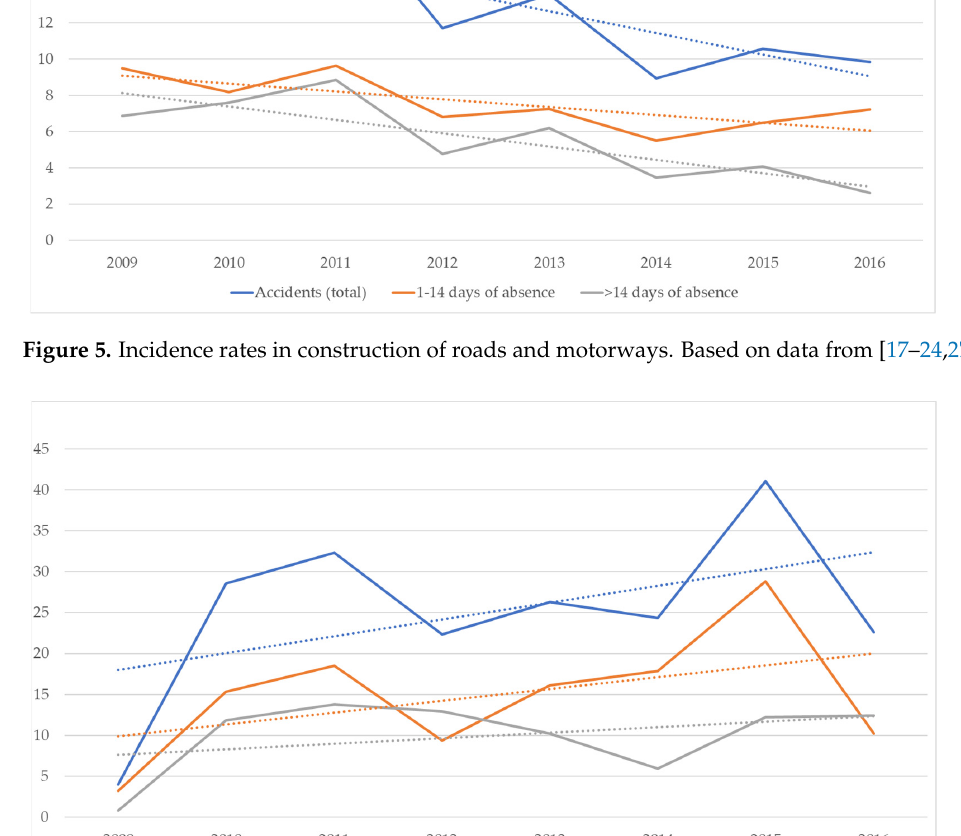
Figure 6. Incidence rates in construction of railways and underground railways. Based on data from [17 – 24,27] .